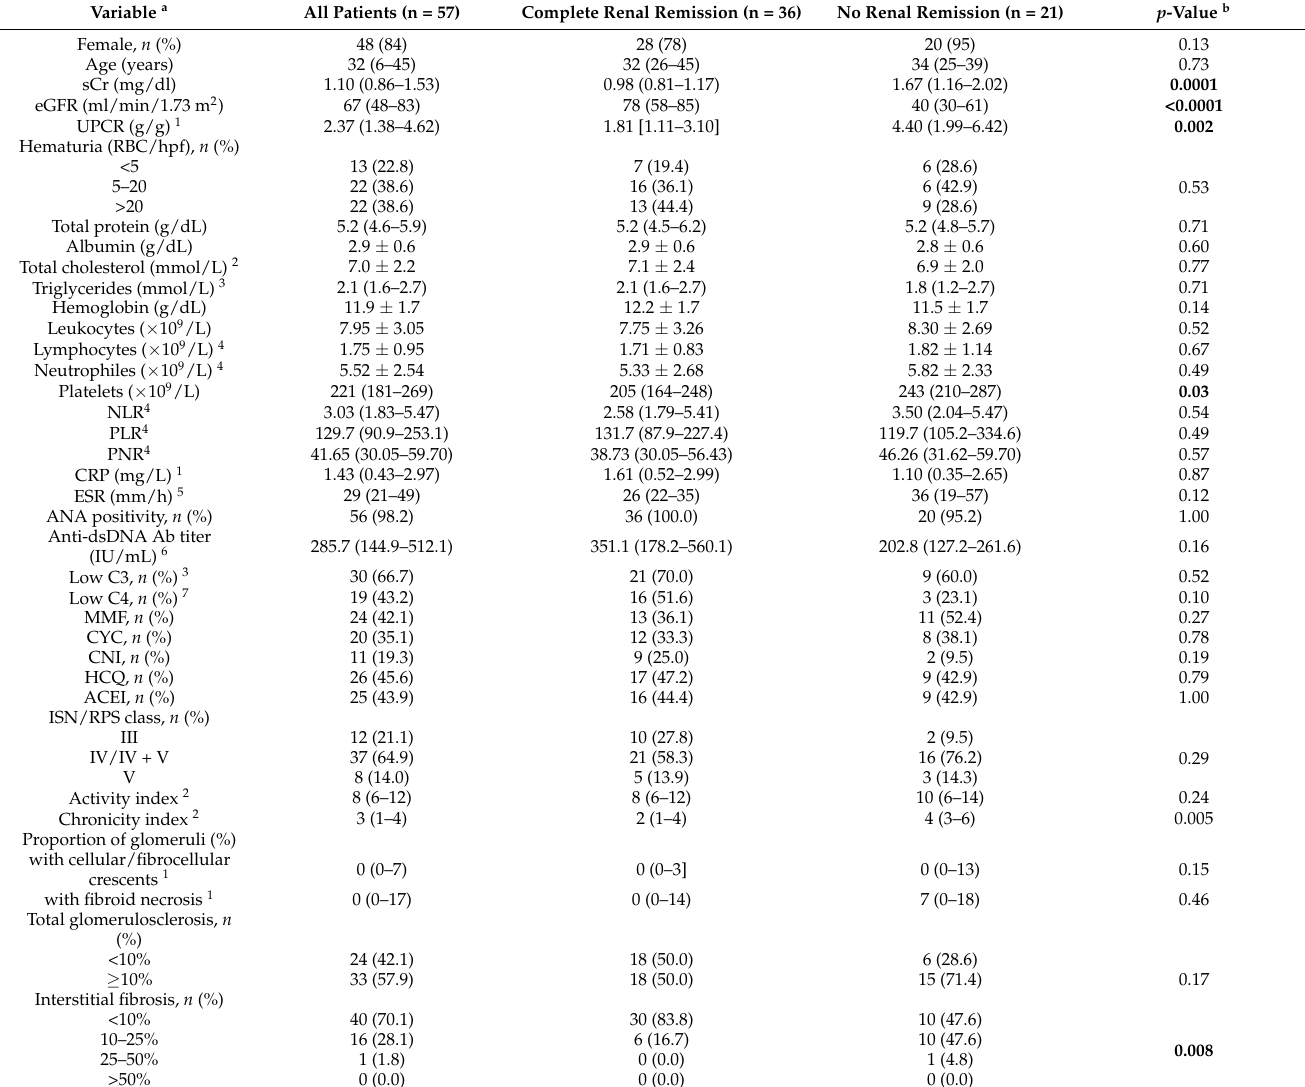
Table 1. Baseline characteristics at the time of renal biopsy according to the remission status within 36 months of the observation